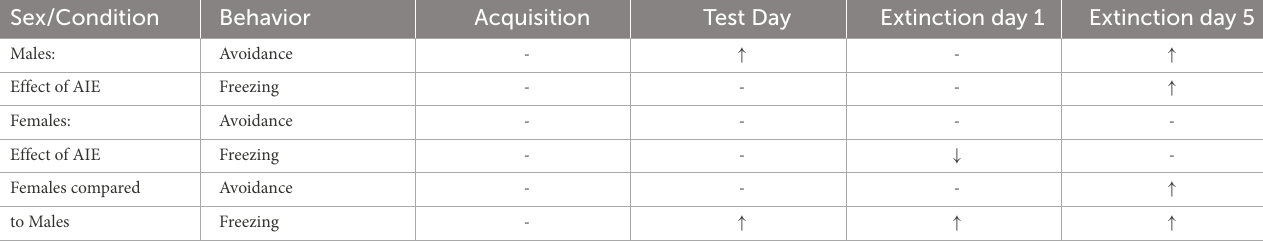
TABLE 1 Summary of effect of sex and AIE exposure on active avoidance and freezing behaviors across acquisition, test day, and extinction.